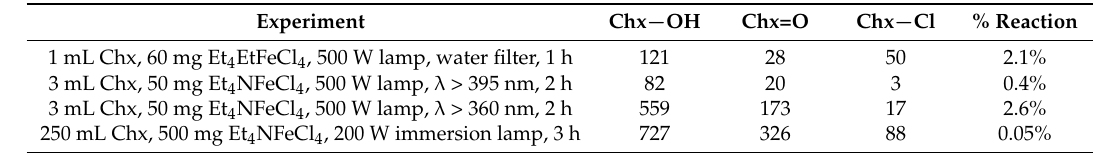
Table 6. Products ( µ mol) from the photolysis of cyclohexane (0.5% acetic acid, 1 mg Bu 4 Br/mL) under 50% O 2 /50% air, other conditions as noted.